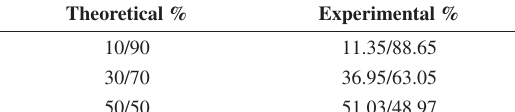
Table 2. Comparison between expected and obtained percentages. Theoretical %